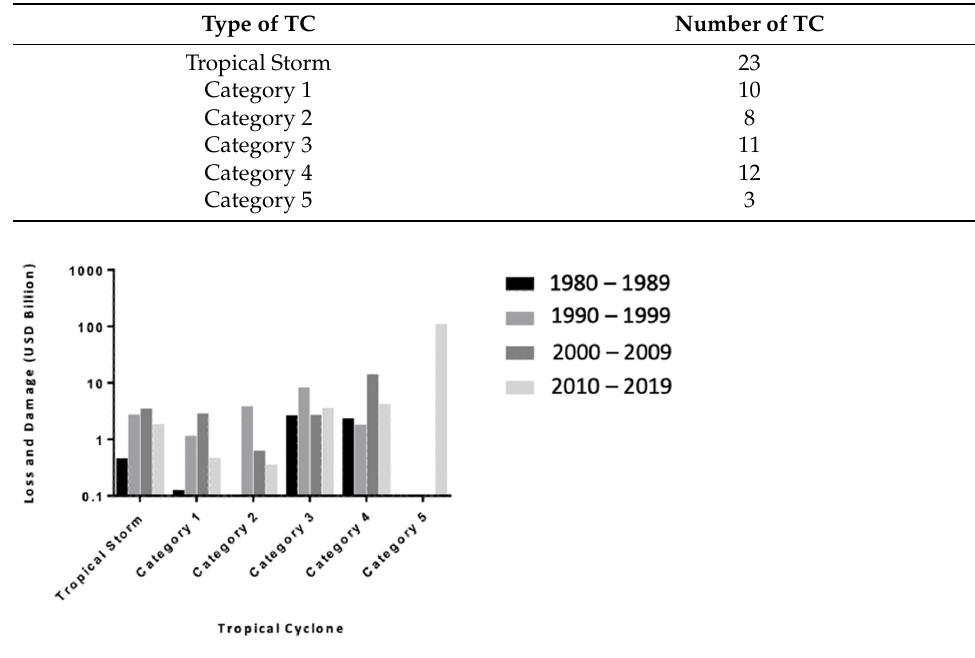
Figure 3. Economic loss and damage incurred by the different categories of TC selected in the Car- ibbean between 1980–2019. Caribbean between